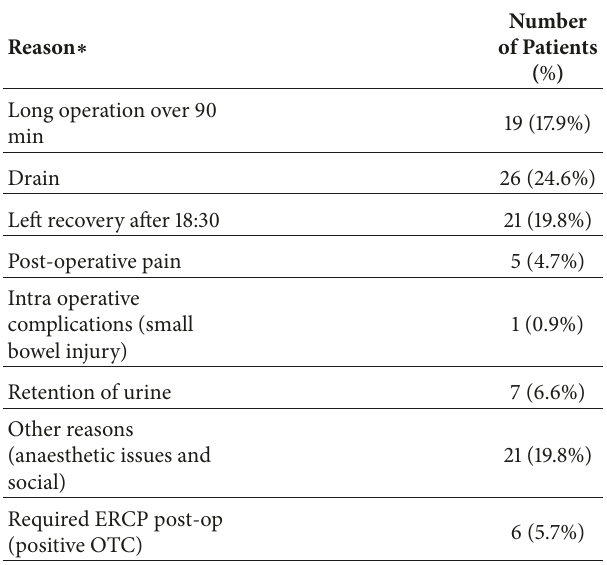
Table 2: Reasons for unexpected overnight admissions